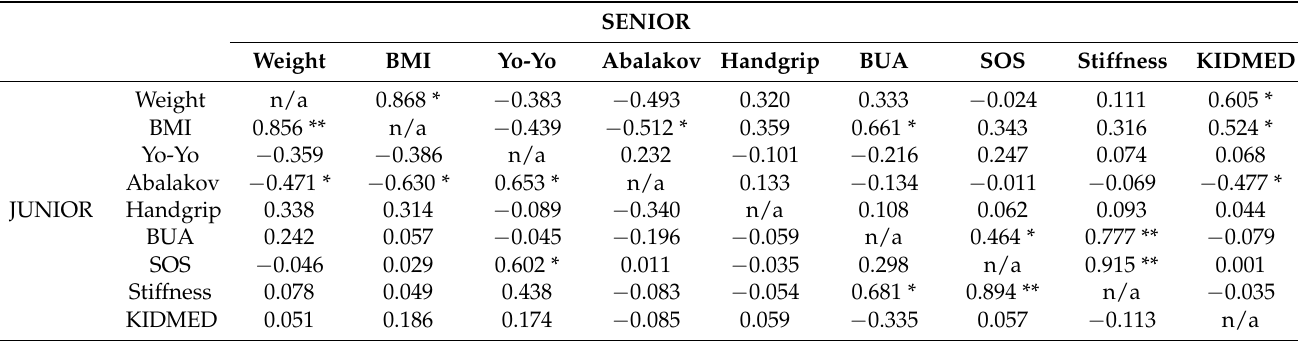
Table 4. Female beach handball players’